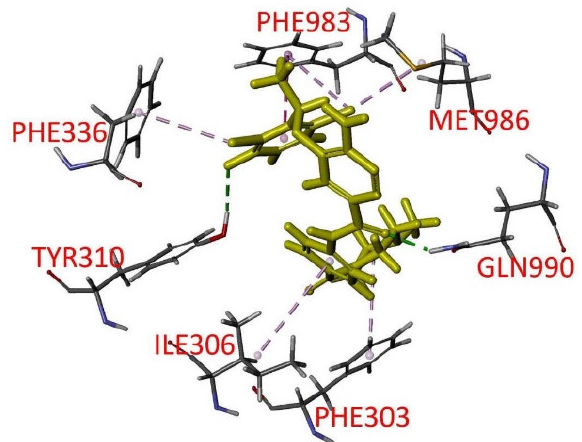
Figure 5. Docking of ensartinib to P-gp. The lowest energy binding mode of ensartinib with Taxol-bound human P-gp (PDB: 6QEX) was predicted by Accelrys Discovery Studio 4.0 software as described in Materials and Methods. The molecular model of ensartinib is highlighted in yellow, and the atoms for interacting amino acid residues carbon, hydrogen, nitrogen, and oxygen are colored gray, light gray, blue, and red, respectively. Dotted lines indicate proposed interactions.